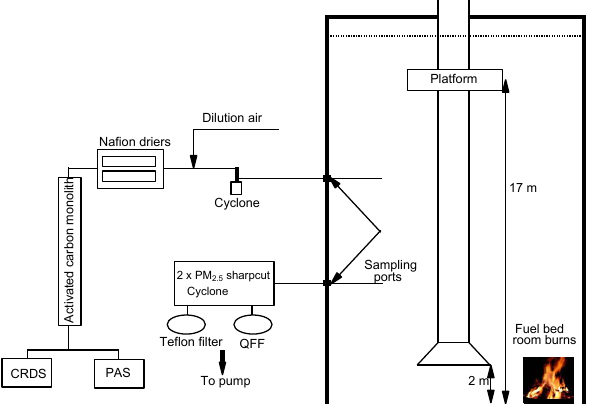
Figure 1. The schematic of instrumental setup during the FLAME-4